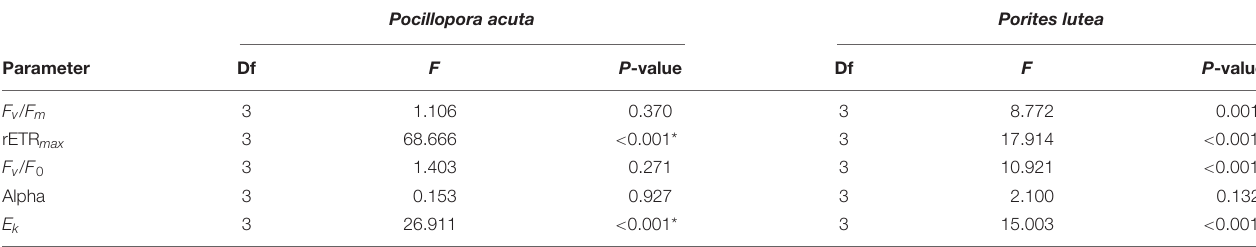
TABLE 2 | Statistical analysis of PAM between treatments (Mixed Two-way Repeated ANOVA). Pocillopora acuta Porites